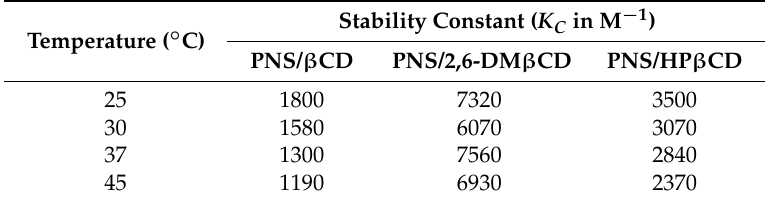
Table 1. Stability constant of all inclusion complexes at different temperatures.